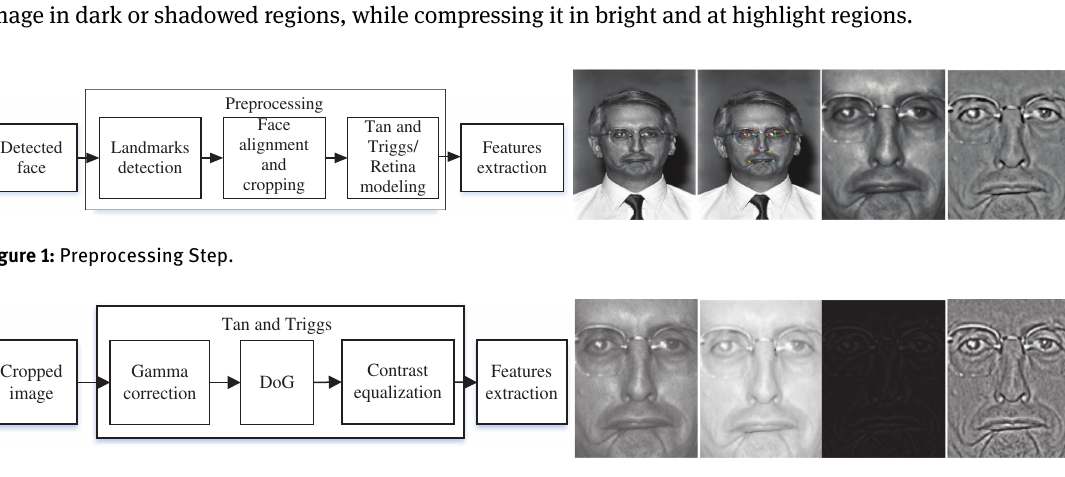
Figure 2: Tan and Triggs